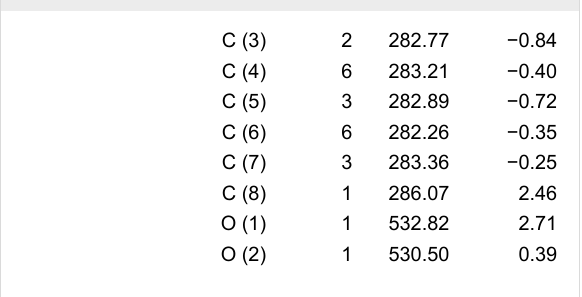
Table 2: Calculation results for the functionalized graphene structures. The columns show: system identifier; formation energy of the defect; target atom of the calculation (see Figure 2); number of target atoms; calculated 1s binding energy; C 1s BE shift with respect to the calcu- lated C 1s energy of pristine graphene or the O 1s BE shift with respect to the calculated O 1s energy of epoxide/hydroxide functional groups, where applicable. (continued)